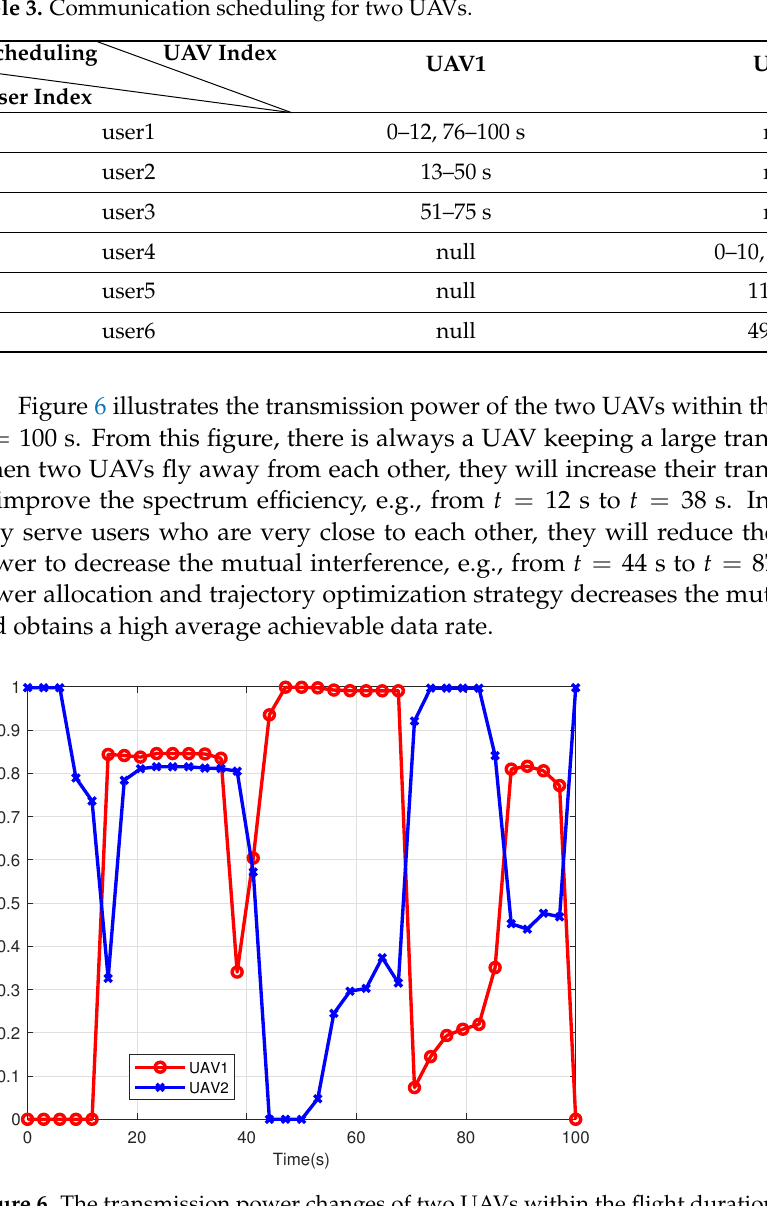
Figure 6. The transmission power changes of two UAVs within the flight duration T = 100